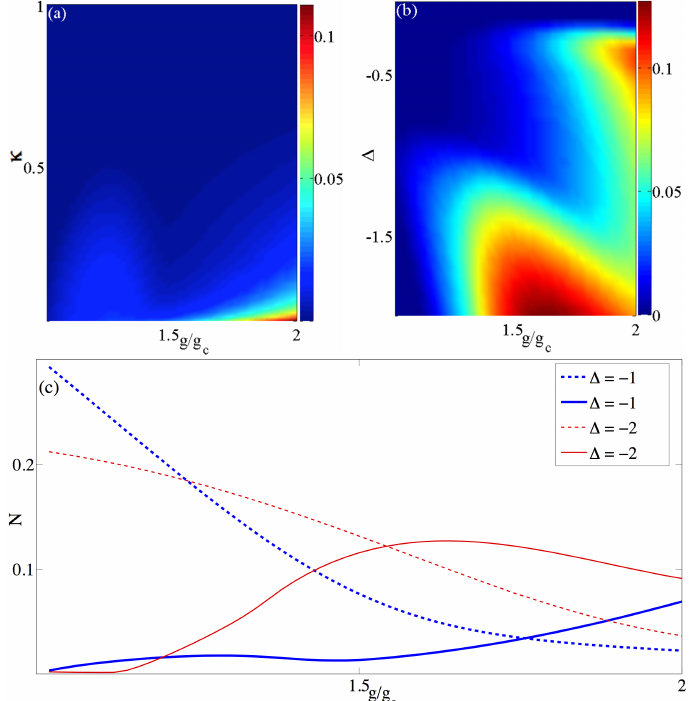
Figure 2. Time-averaged bipartite entanglement (logarithmic negativity N ) between the two condensates as a function of ( a ) κ and g/g for δ = − 1 and ( b ) δ and g/g for κ = 0.05. ( c ) The c c time-averaged cavity-BEC (dashed) and BEC-BEC (solid) entanglement for two different values of the parameter δ and κ = 0.05. The rise of atomic entanglement as the atom-photon entanglement decreases is again an outcome of the entanglement sharing mechanism. Other = 1 physical parameters include ω R